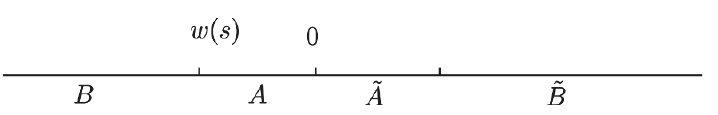
Figure 1 . EoP for the connected two